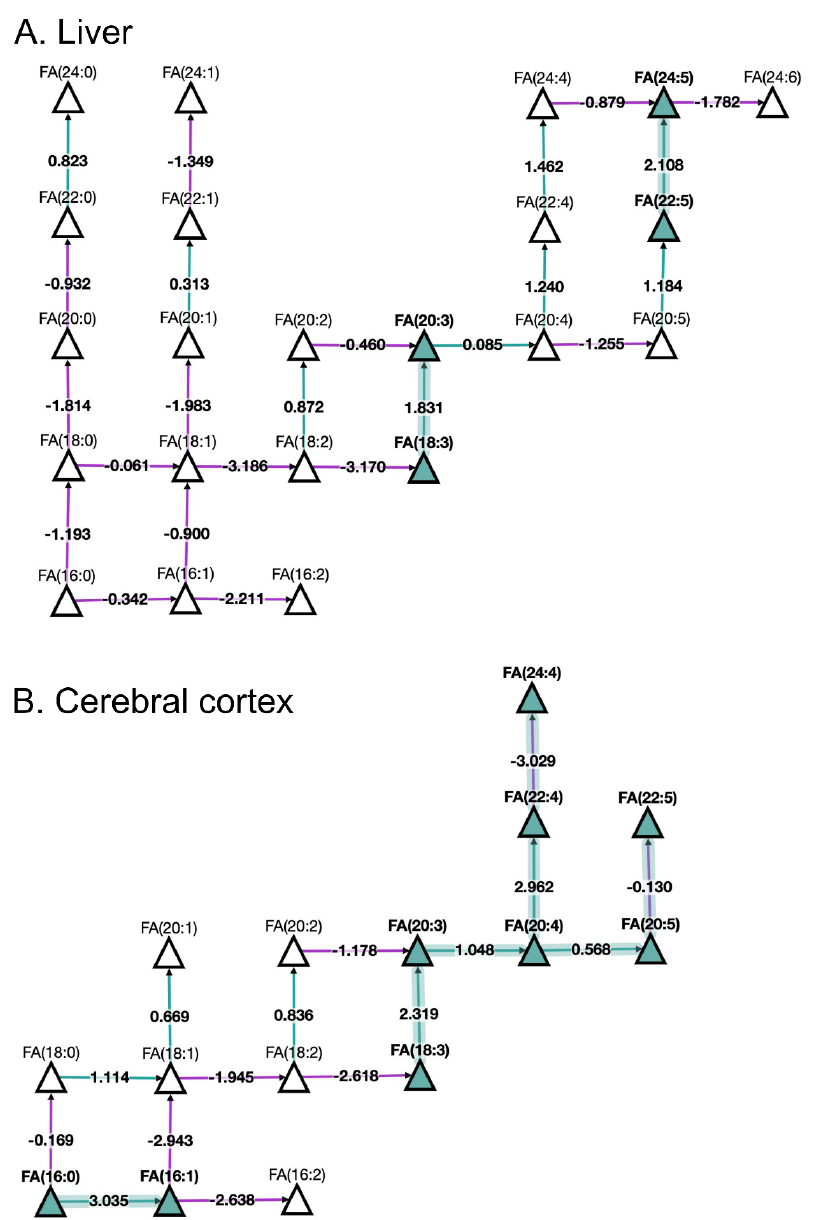
Figure 3. BioPAN fatty acids networks. FA graphs exported from BioPAN tool for the liver ( A ) and the cerebral cortex ( B ) of aged mice compared to young mice 17 . Green nodes correspond to active lipids and green shaded arrows to active pathways. Reactions with a positive Z score have green arrows while negative Z scores are coloured purple. Pathways options: aged condition of interest, young control condition, lipid type, active status, subclass level, reaction subset of lipid data, p value 0.05, and no paired-data.